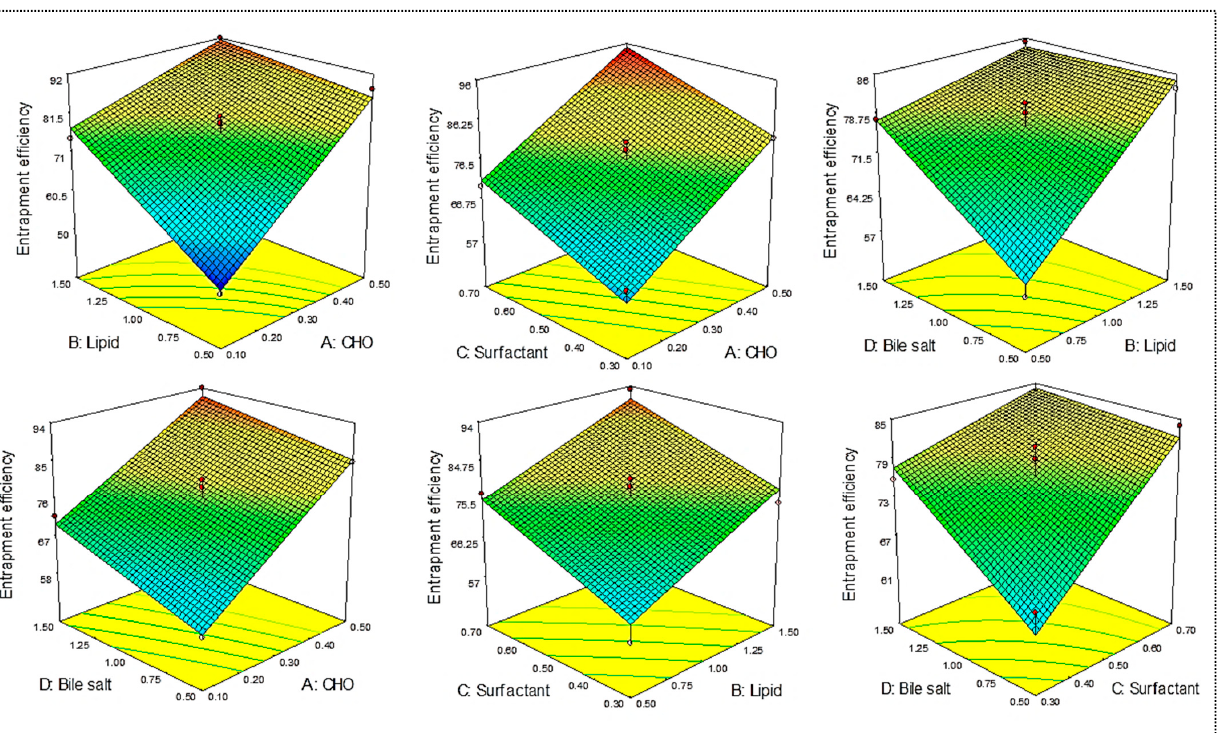
Figure 2. Effect of independent variables lipid (A), cholesterol (B), Pluronic F127 (C), and bile salt (D) on entrapment efficiency (R 2 ). on entrapment efficiency (R 2